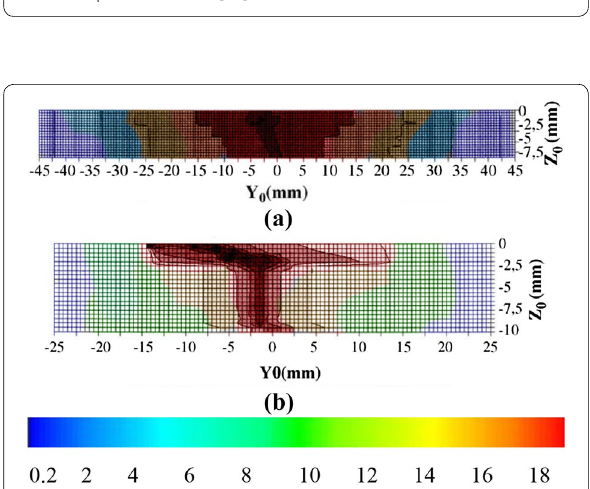
Figure 52 Distribution of the temperature: ( a ) the cross-section, ( b ) the transverse movement direction